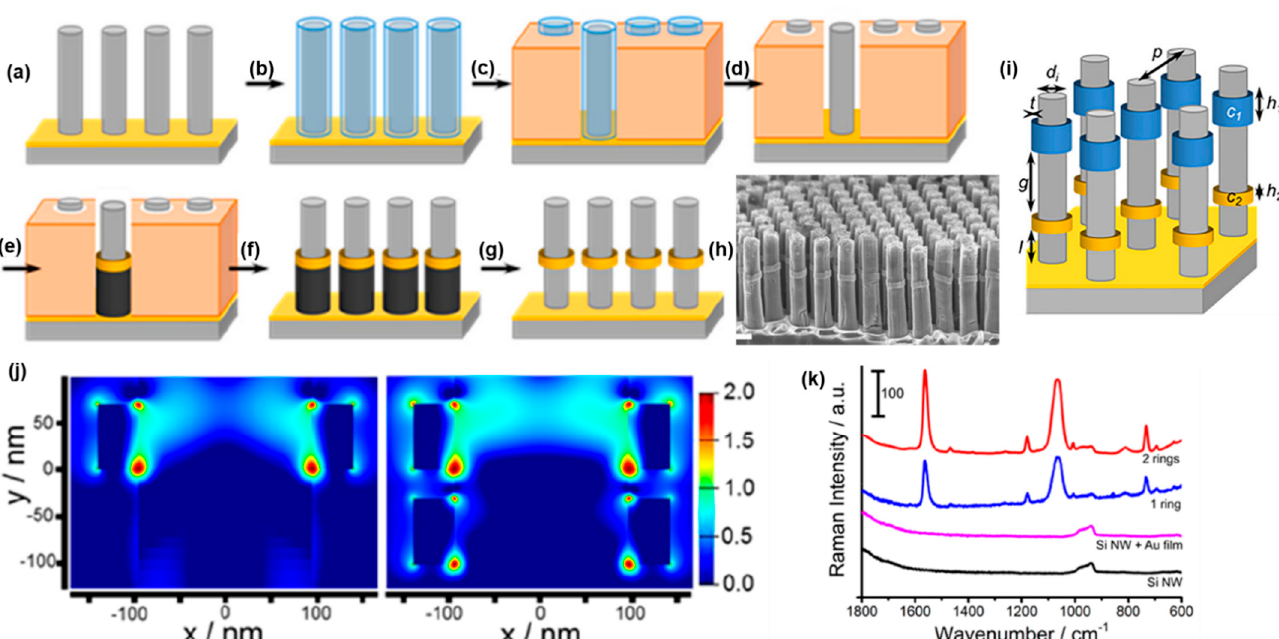
Figure 14. Three-dimensional electrochemical axial lithography (3DEAL). ( a − g ) Scheme showing the synthesis steps. The Si nanowires (in gray) are conformally coated with a SiO 2 shell (in blue) and embedded within a polymer (orange). The dissolution of the SiO 2 shell generates annular pores around the Si nanowires. The pores guide the electrodeposition of multisegmented shells around the Si nanowires, starting from the Au film at the bottom (here: nickel shown in black and Au in yellow). Dissolution of the polymeric membrane and selective etching of the sacrificial shell (here: nickel) leads to a well-defined metal shell (here: a Au ring). ( h ) Secondary electron SEM image of a Si microwire array with a Au ring. Scale bar is 1 µm. ( i ) Scheme showing the geometric parameters that can be controlled using 3DEAL, including the Si nanowire diameter and pitch, the outer diameter, height, and axial position of the nanorings. ( j ) E-field enhancement maps of regions of Si nanowires with one Au ring (left) and two Au rings (right). The incident light propagates along the y axis, and the electric field is polarized along the x axis. Excitation wavelength is 785 nm. The scale for the E-field enhancement is logarithmic. ( k ) Raman spectra of 1,4 − benzenedithiol − functionalized Si nanowires (black curve), Si nanowires with a Au film at the bottom (magenta curve), a Si nanowire array with a single Au ring (blue curve), and a Si nanowire array with two Au rings spaced by a 30 nm gap (red curve). Reprinted with permission from ref. [31]. Copyright 2018 American Chemical Society. Further permission related to the material excerpted should be directed to the